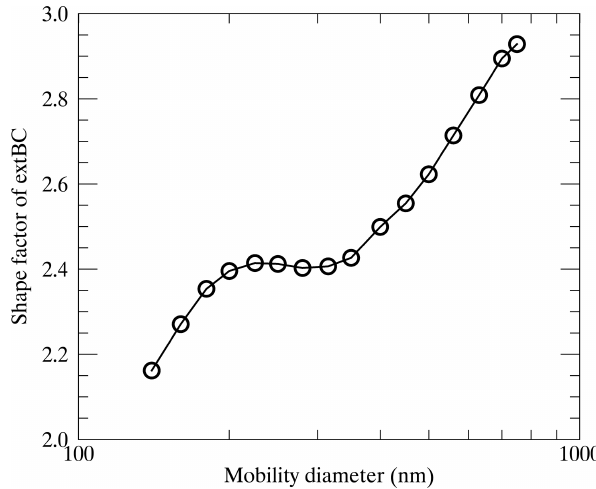
Figure 5. The dynamic shape factor of the extBC particles as a func- tion of the mobility diameter in the range of